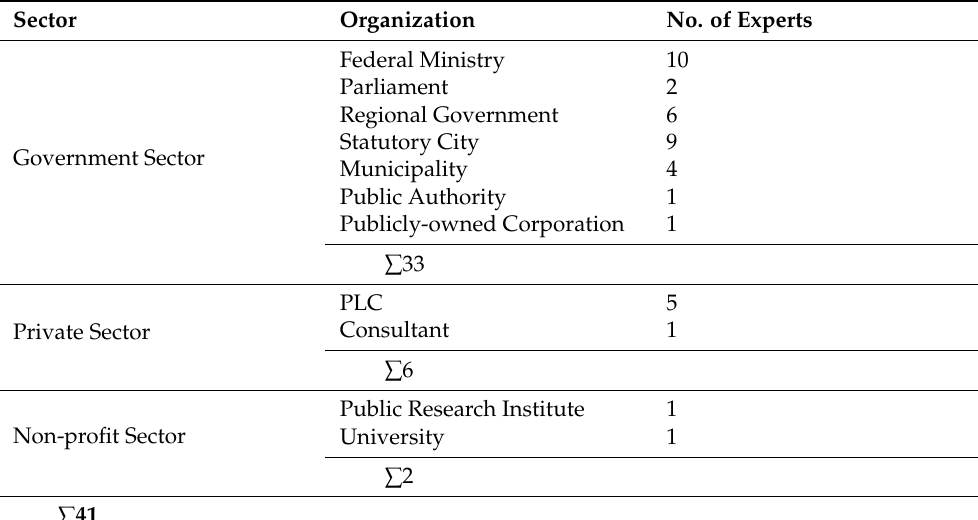
Table 1. Experts’ by sector and